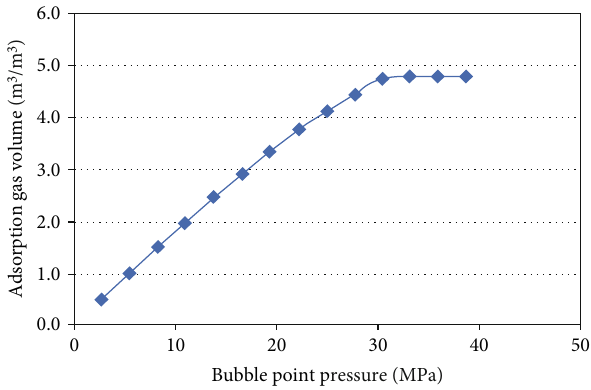
Figure 11: Langmuir isothermal adsorption